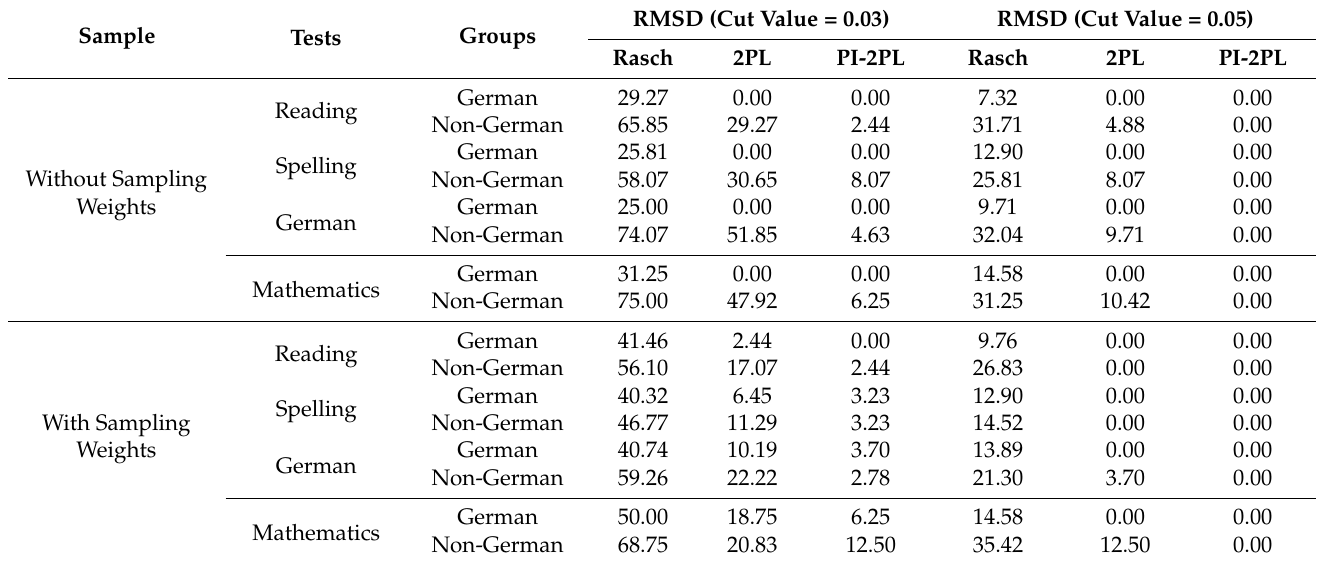
Table 6. Proportion (%) of misfit items for German and non-German students in the